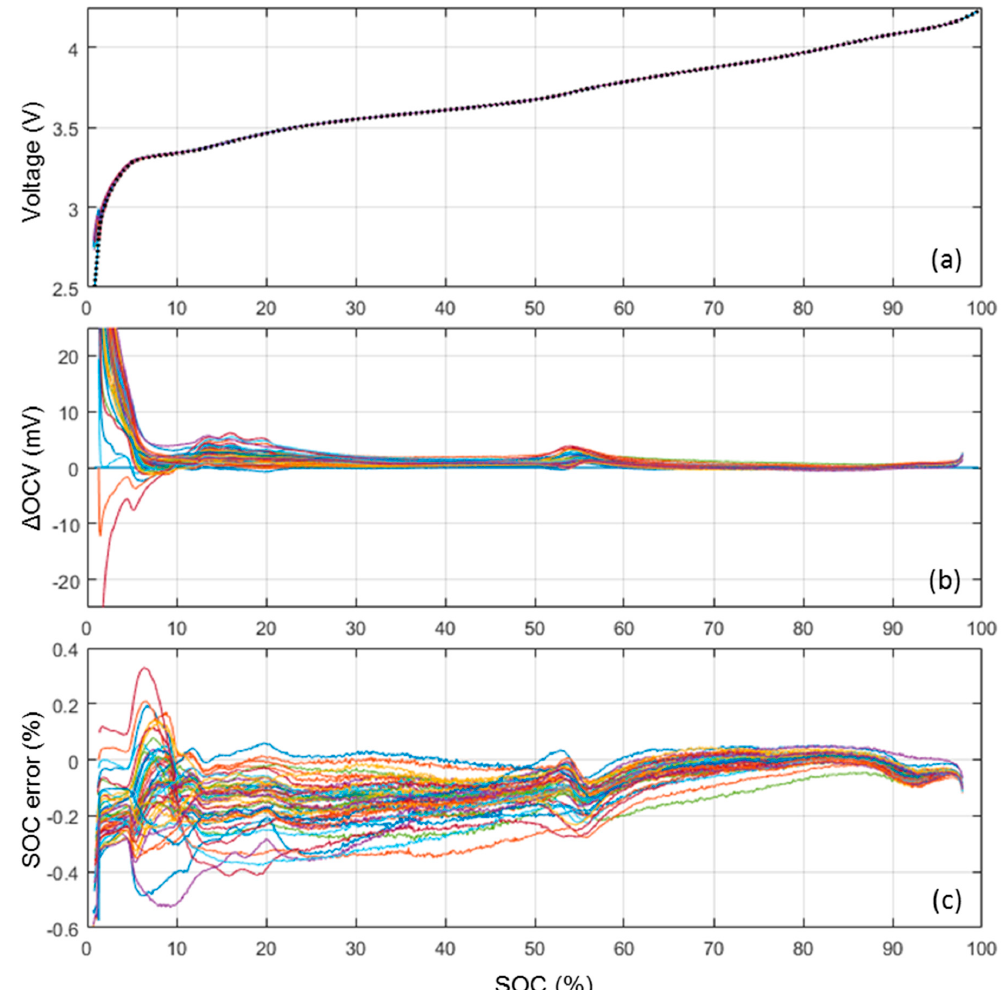
Figure 3. ( a ) ps- OCV = f ( SOC ) calculated from the nominal sample cell (dotted line) and the 50 cells subjected to a C/35 cycle; ( b ) corresponding OCV variations; and ( c ) associated state of charge (SOC